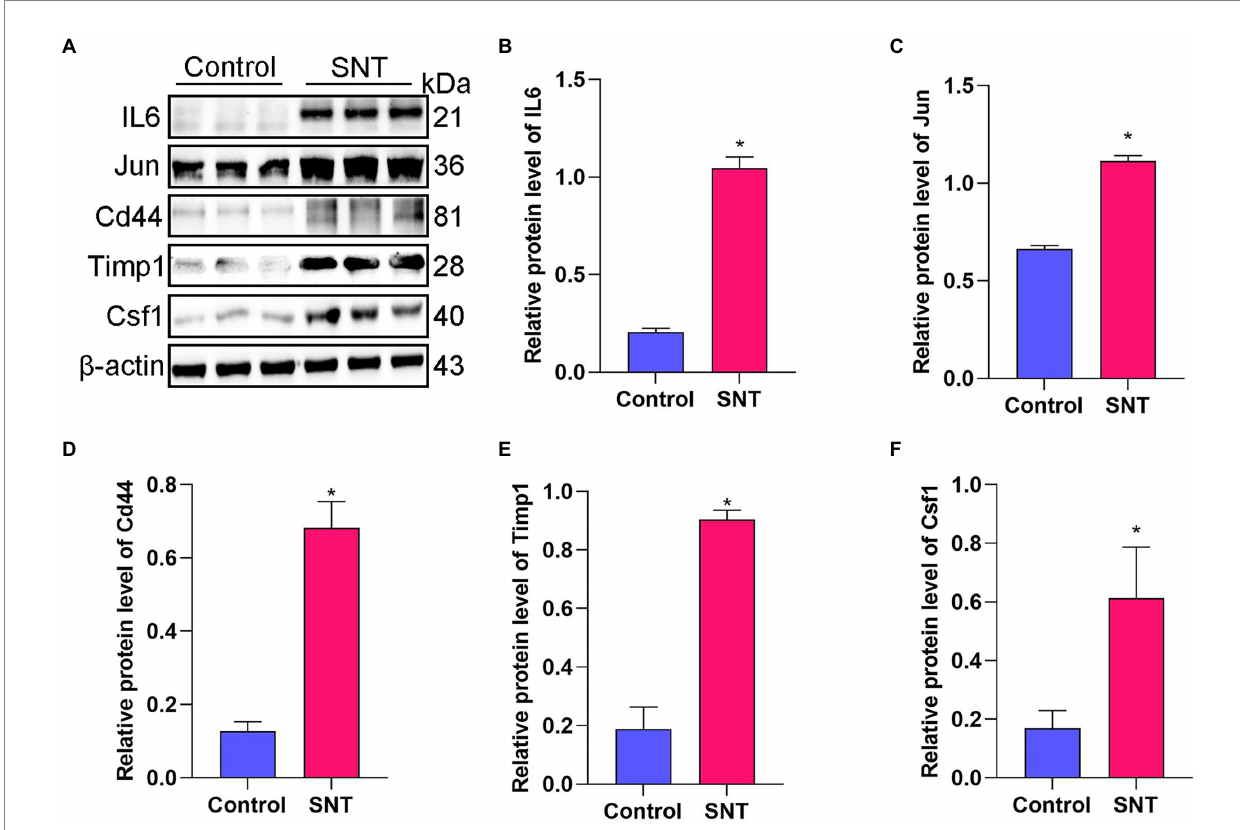
FIGURE 4 Verification of the top 5 hub genes. (A) The expression of the IL6, Jun, Cd44, Timp1 and Csf1 in DRG tissues of mice induced by SNT and the control by Western blot. (B–F) The expression analysis of the IL6, Jun, Cd44, Timp1 and Csf1. Data are presented as means ± SD ( n = 3; * p <